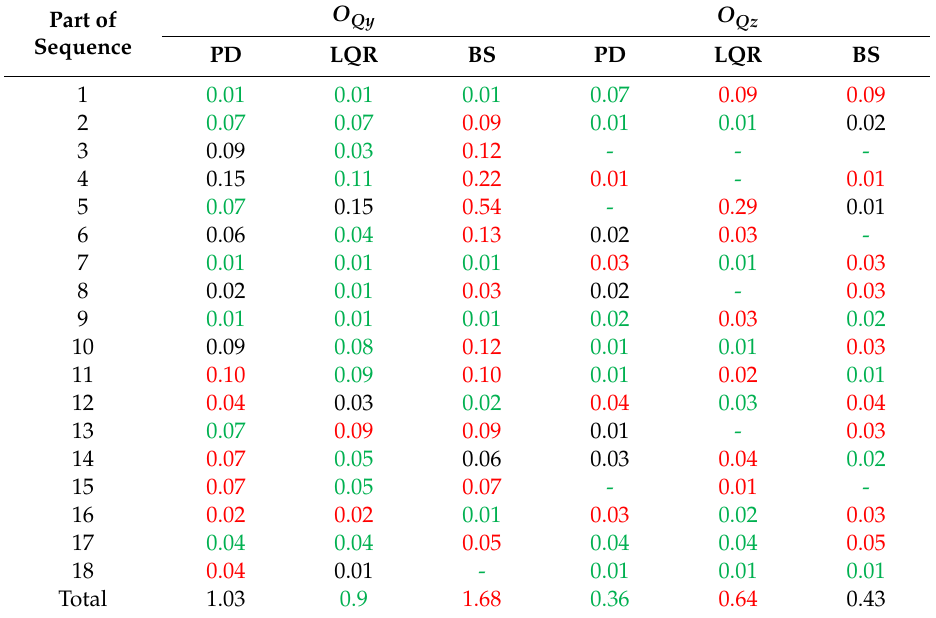
Table A7. Quality indicators of controllers’ performance: Maximal absolute variation of the vector part of quaternion related to y axis ( O Qy ) and z axis ( O Qz ) (PD—PD controller, LQR—LQR controller, BS—backstepping